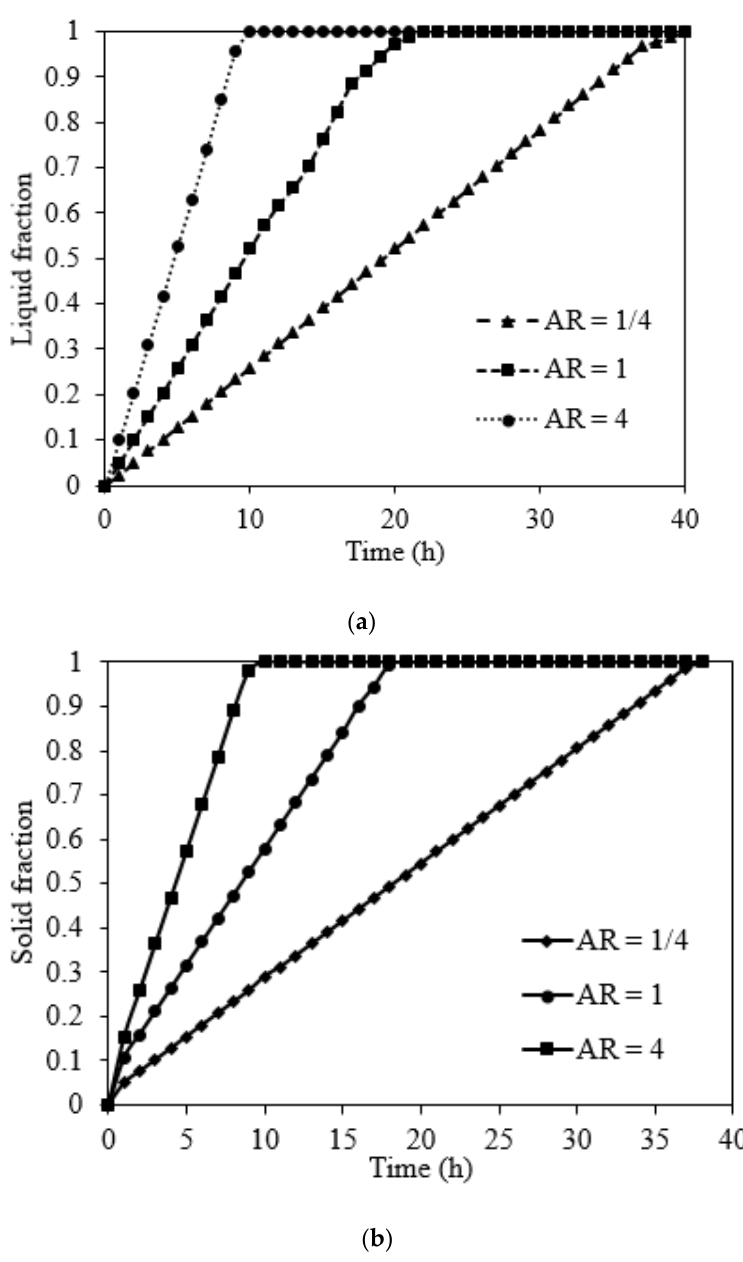
Figure 14. Influence of orientation of domain on charging and discharge performance. (a) Charging ; (b) Discharging